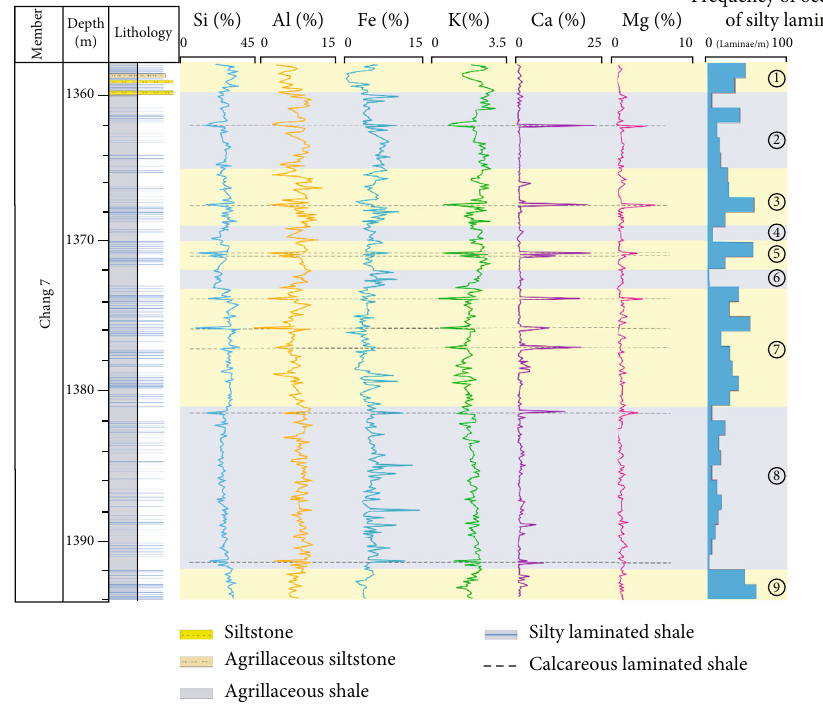
Figure 7: Lithology and element content of shale strata in Well Y1. Table 3: Element contents of shale layers ① ~ ⑨ in Well Y1.